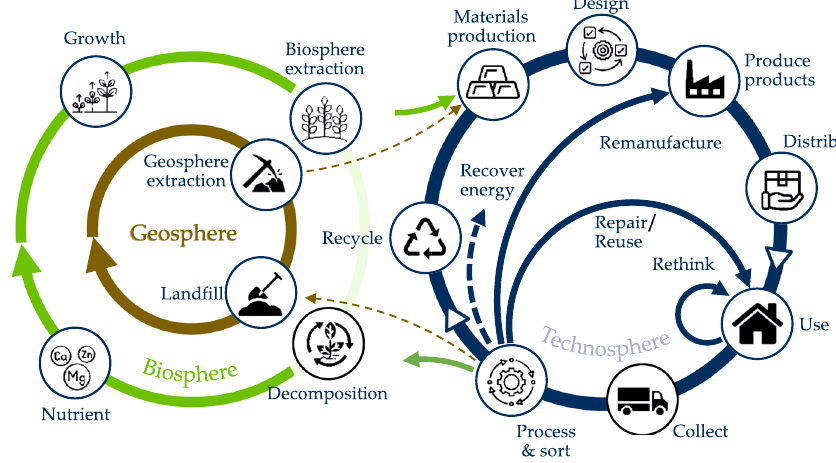
Fig. 7 Circular economy con- cept describing the material flow with its interfaces to geo- and biosphere and unavoid- able waste streams (leaned on [71,